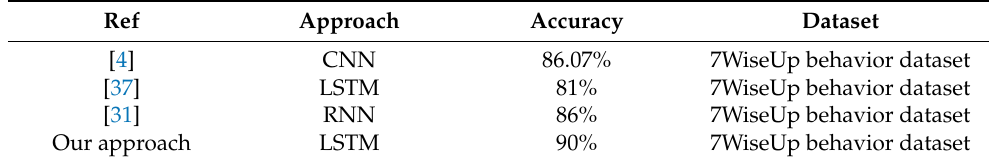
Table 4. Proposed model comparison with related